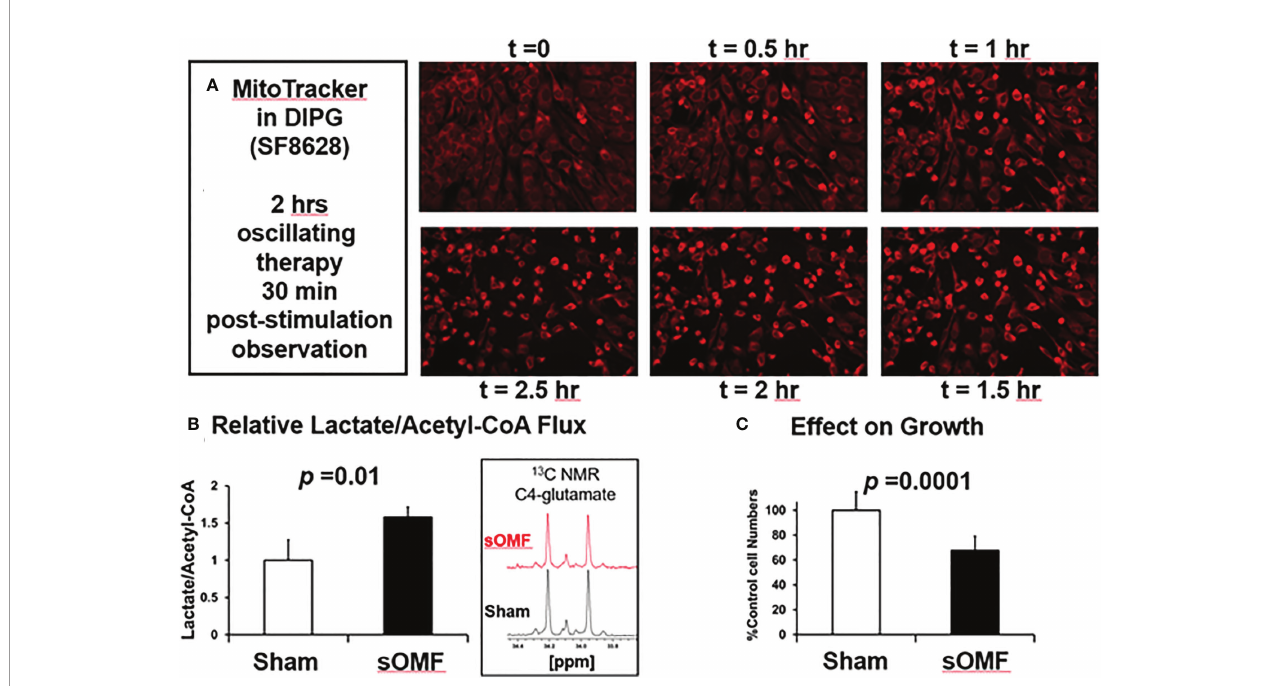
FIGURE 7 | sOMF treatment of SF8628 DIPG cells causes cell death and mitochondrial changes. (A) Effects of sOMF in paired sOMF/sham-treated SF8628 DIPG cells, preincubated with MitoTracker ™ . Fluorescence microscopic images, taken every 30 min during two hours of sOMF treatment and at 30 min post-treatment show classical morphological changes indicative of cell death, which were not observed in control cells (data not shown). (B) 13 C-glucose metabolism studies show that 4-h sOMF stimulation elevates anerobic/aerobic fl ux of DIPG cell cultures by ≈ 60% ( n = 3, p = 0.01), based on levels of 13 C-lactate and 13 C-glutamate (insert). (C) Viability dye Hoechst 33342 studies performed 44 hours after 4 h of sOMF or sham stimulation of SF8628 DIPG cells show a ≈ 40% drop in viable cells ( p <0.0001) due to